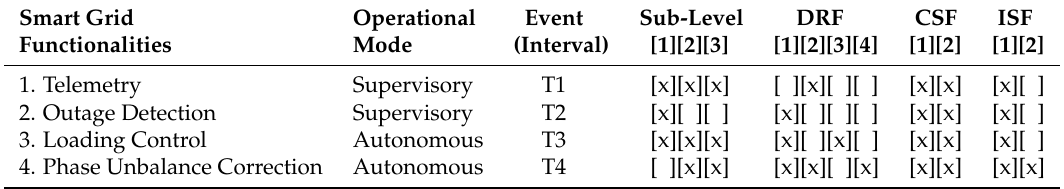
Table 3. Smart grid functionalities list performed in the experiment and their respective